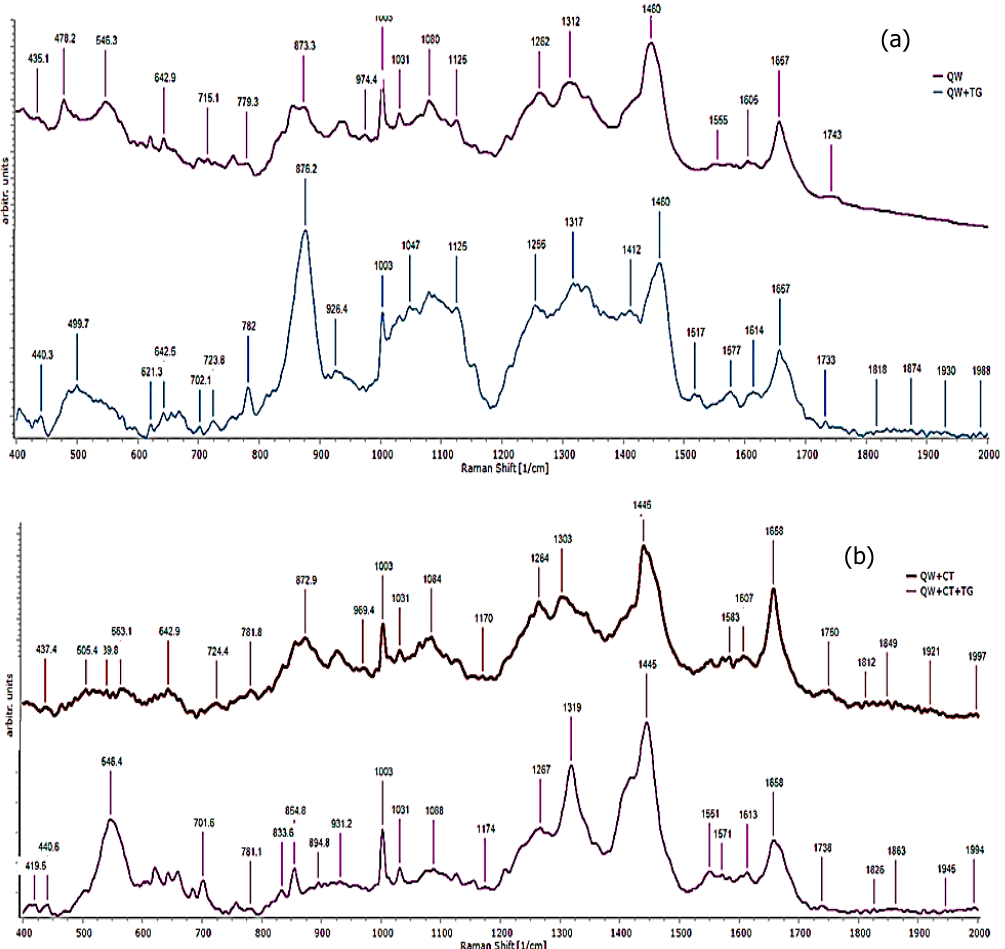
Figure 6. RAMAN spectrogram of QW and CT:QW (1:10) films. ( a ) QW and QW + TG; ( b ) CT-QW (1:10, w / w ) and CT:QW (1:10, w / w ) + TG. QP = Quinoa Pasankalla; QW = Quinoa Willd; CT =